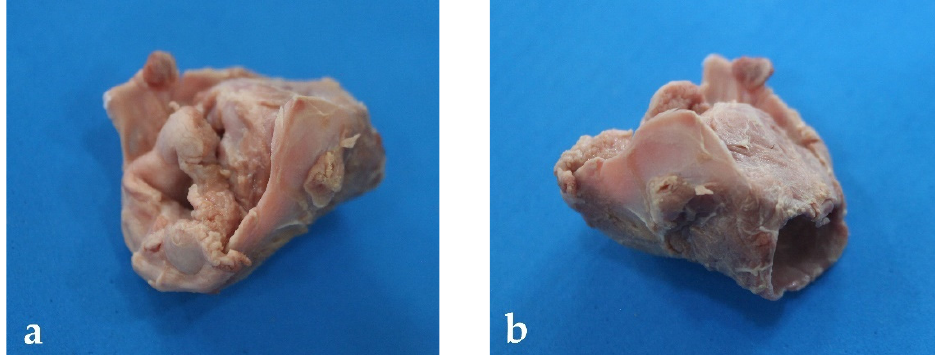
Figure 3. Larynx of Arctocephalus australis : ( a ) oblique view of the rostral larynx; ( b ) oblique view of the caudal larynx. the caudal